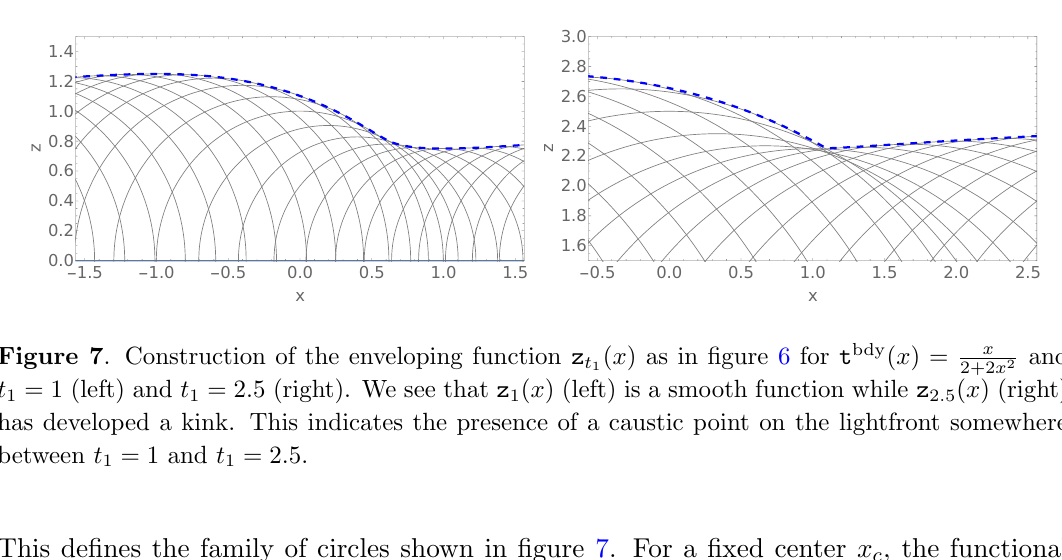
( x ) as in (cid:12)gure 6 for t bdy ( x ) = x and 2+2 x 2 1